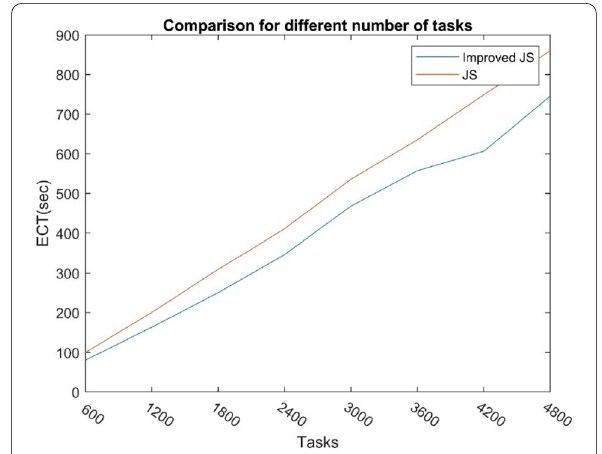
Fig. 7 ECT v/s number of tasks